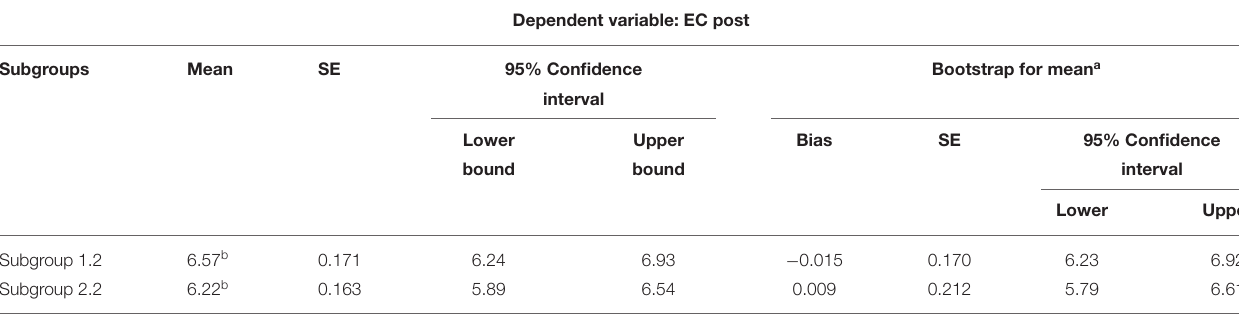
TABLE 8 | ANCOVA estimated means for closed to experience.